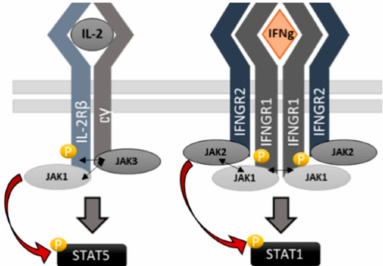
Figure 6. Illustration of the suggested activation cascades in IL2R and IFN γ R systems. Left : Binding of IL-2 induces dimerization of the receptor subunits, possibly via JAK1 and JAK3 JH2-JH2 and FERM-FERM interaction allowing JAK1 / 3 transphosphorylation and activation leading to activation of STAT5 by JAK1. Right : In IFN γ R JAK2 mediates STAT1 phosphorylation while JAK1 contributes by phosphorylating the IFNGR1, hence creating a docking site for the STAT1 and strengthening the oligomerized complex